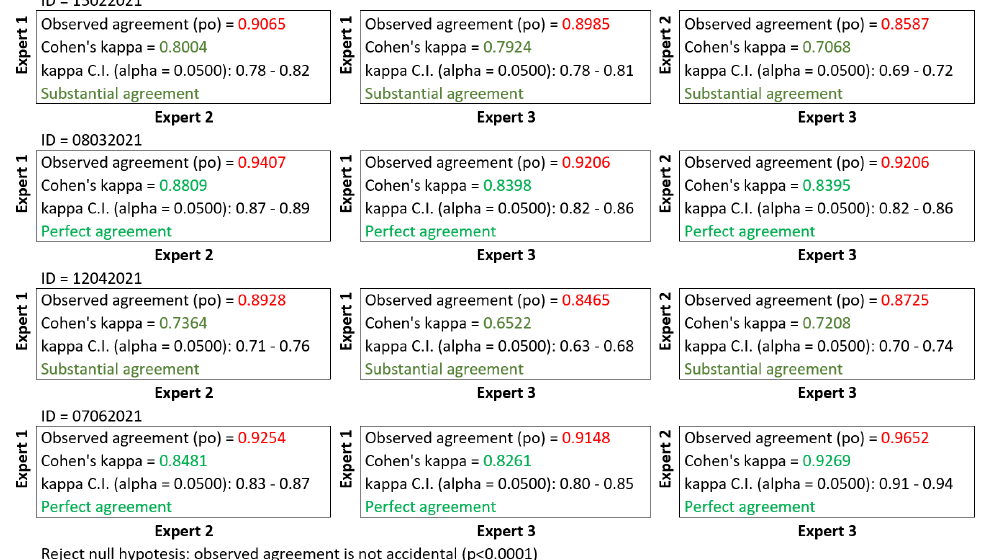
Figure 3. Inter/intra-observer agreement—unweighted Cohen’s Kappa.